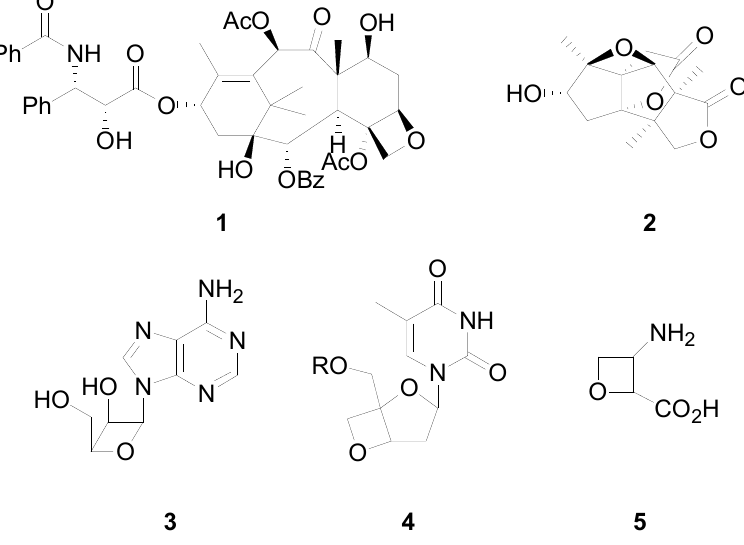
Scheme 1. The reaction performed by Paternò.